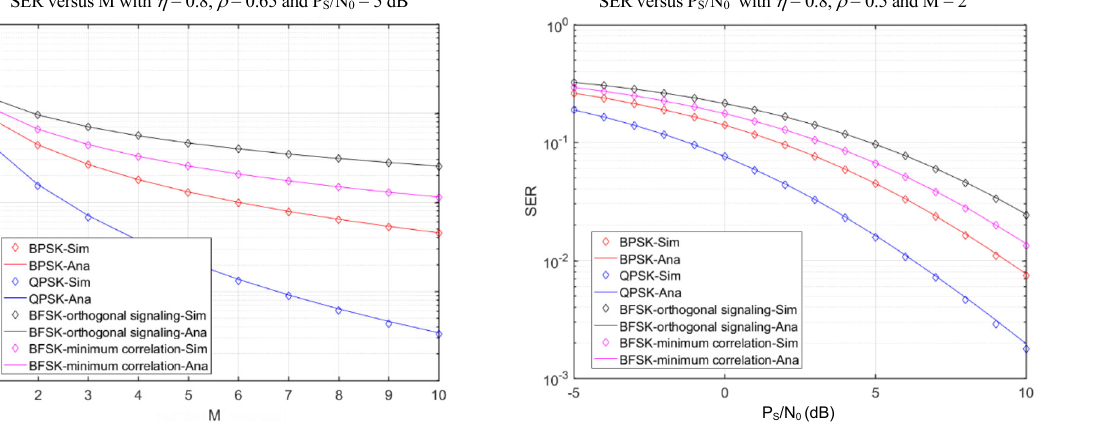
Fig. 7. SER versus the number of sources M . Fig. 8. SER versus the source power to noise ratio P